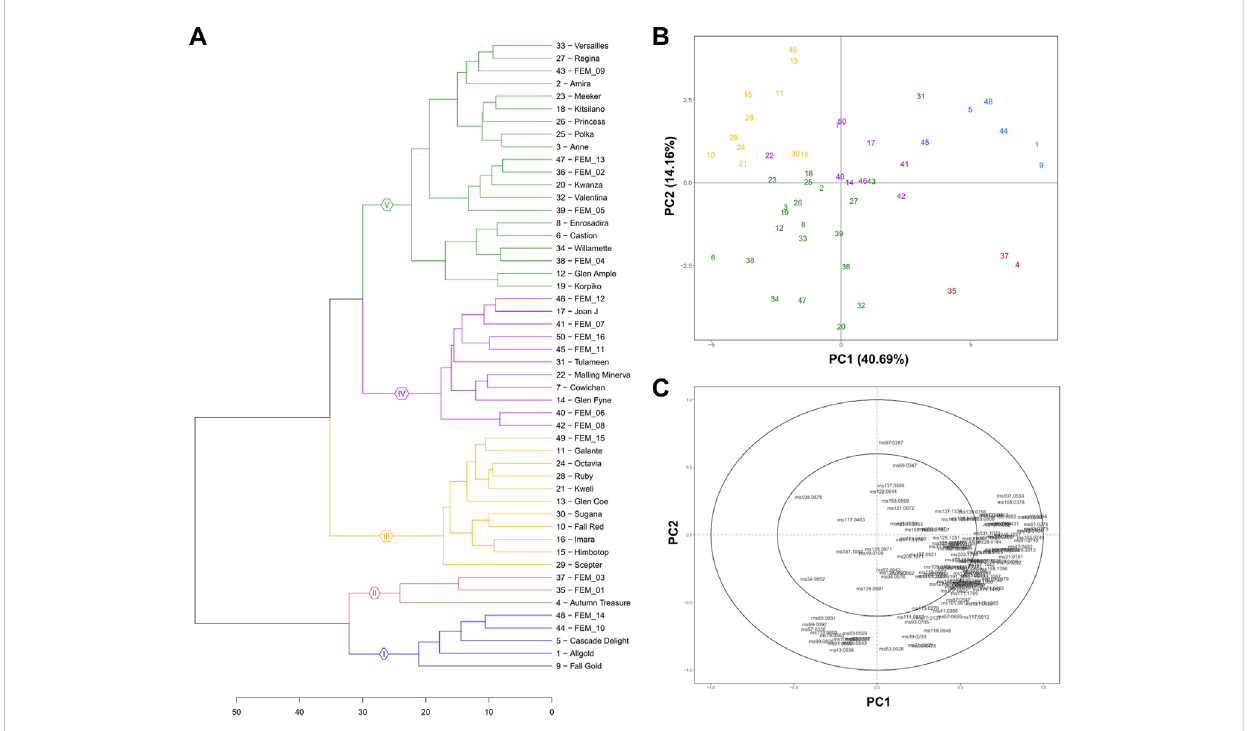
FIGURE 5 RaspberrygermplasmvolatilomeassessedbyPTR-ToF-MS.Hierarchicaldendrogram (A) principalcomponentanalysis(PCA) (B) andloadingplot (C) of VOC pro fi les of 50raspberry accessions measured by PTR-ToF-MS. Each VOC concentration is theaverage of three biological replicates. Each colour of the PCA plot depicts one of the fi ve clusters, determined by gap